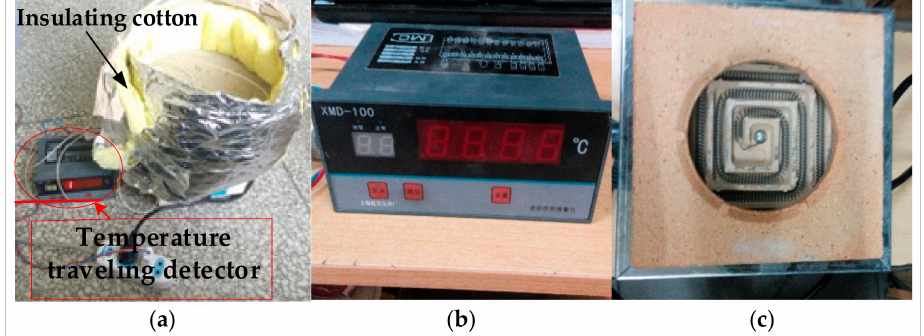
Figure 7. Thermal insulation test of rubberized concrete: ( a ) Heating the specimens, ( b ) XMD-100 temperature traveling detector, and ( c ) the electric